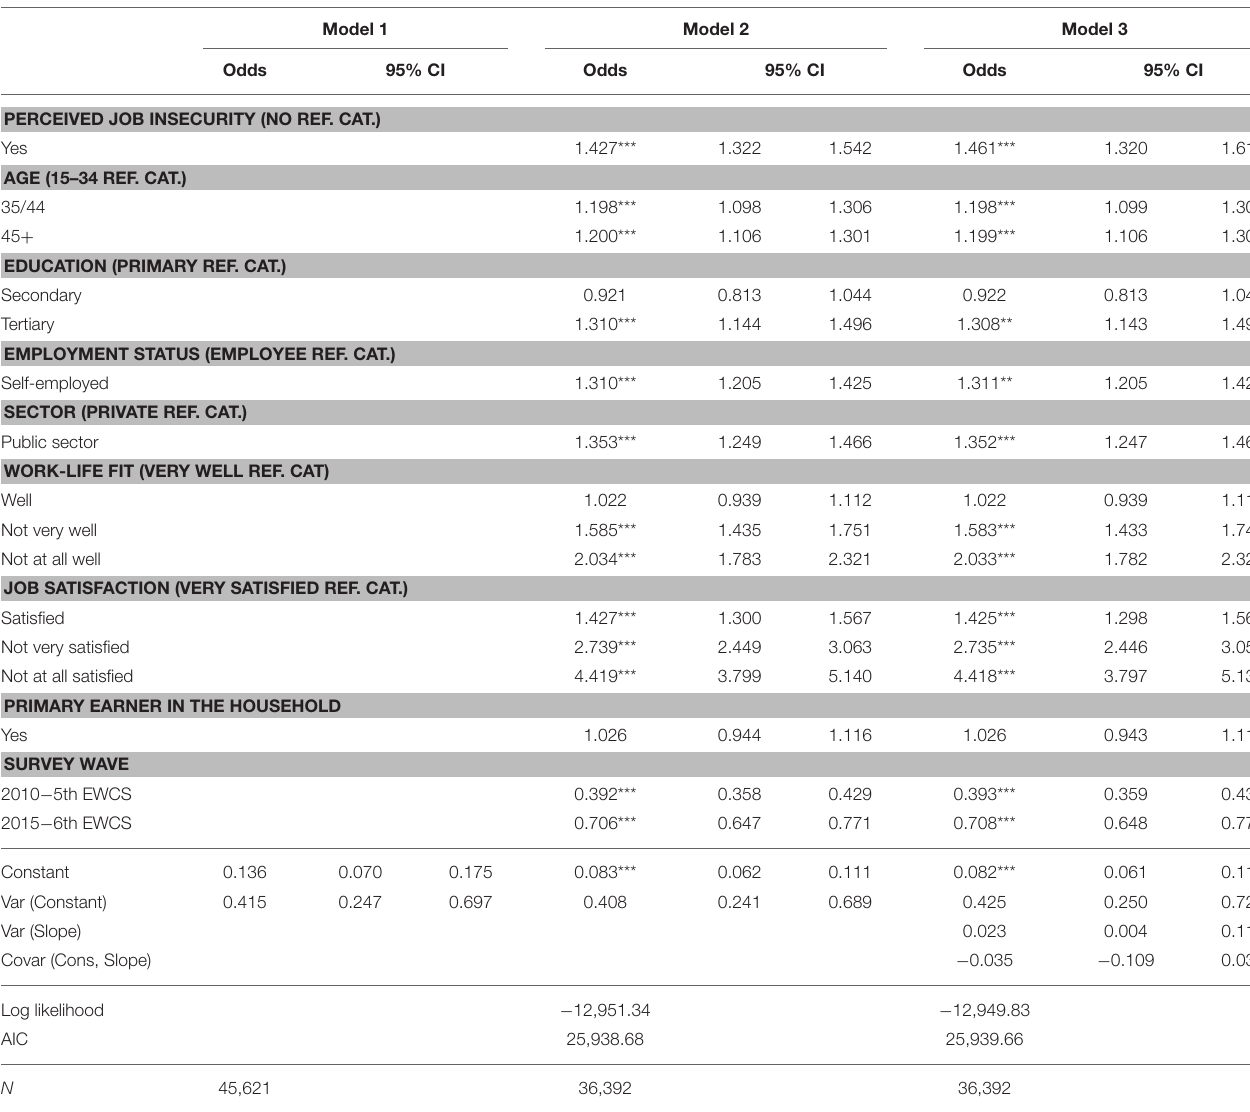
TABLE 3 | Results of mixed-effects logistic regression model (male